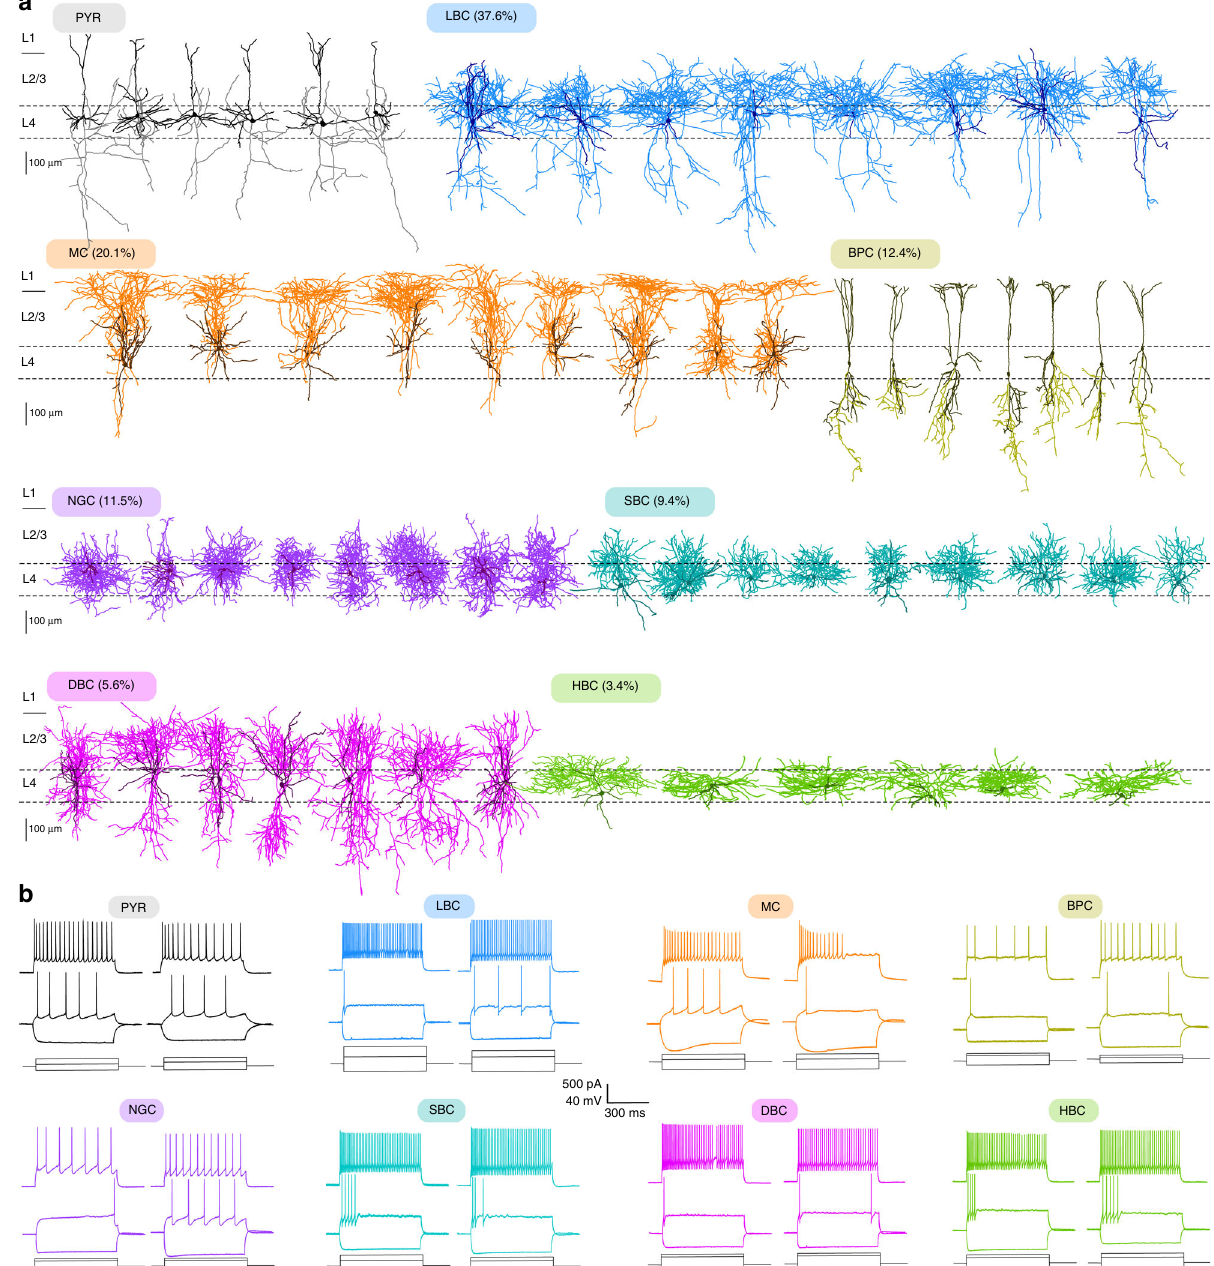
Fig. 1 Morphological cell types in V1 L4. a Representative morphologies for each cell type. The dendrites are shown in a darker shade of color and axons in a lighter shade. Types are sorted by abundance from high to low. Fractions indicate the proportions among the neurons labeled in Viaat-Cre mice. PYR: pyramidal cells, LBC: large basket cells, MC: Martinotti cells, BPC: bipolar cells, NGC: neurogliaform cells, SBC: small basket cells, DBC: double-bouquet de fi ned cell